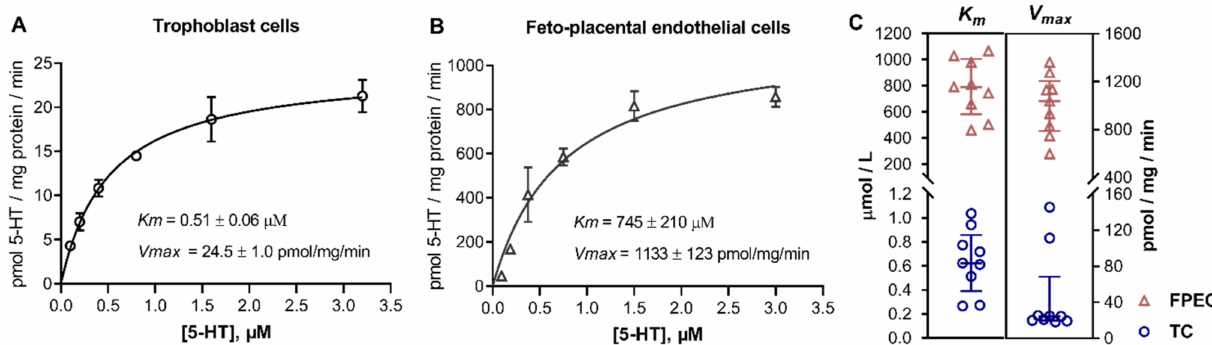
Figure 2. Kinetic analysis of the uptake of 5-HT into human primary placental cells. Human primary ( A ) trophoblasts and ( B ) feto-placental endothelial cells were incubated in the presence of six increasing 3 H-5-HT concentrations between ( A ) 0.1 and 3.2 µ M and ( B ) 94 and 3000 µ M for 2 and 8 min, respectively. The specific uptake was calculated as the difference between transport at 37 ◦ C and on ice. The initial rates of specific uptake were plotted against substrate concentration and fitted to the Michaelis–Menten kinetics model. Data (mean ± SD, n = 3) from one of the nine subjects studied are shown. ( C ) Best-fit values of the Michaelis affinity constant ( Km ) and maximal transport velocity ( Vmax ) obtained in trophoblast cells (TC) and feto-placental endothelial cells (FPEC) isolated from different placentas (n = 9 for each cell type). Lines represent the medians and interquartile range (for numerical results, see Table S1). Values of Km and Vmax were significantly different between trophoblasts and feto-placental endothelial cells ( p < 0.0001 in both cases; t -test or Mann–Whitney test, as